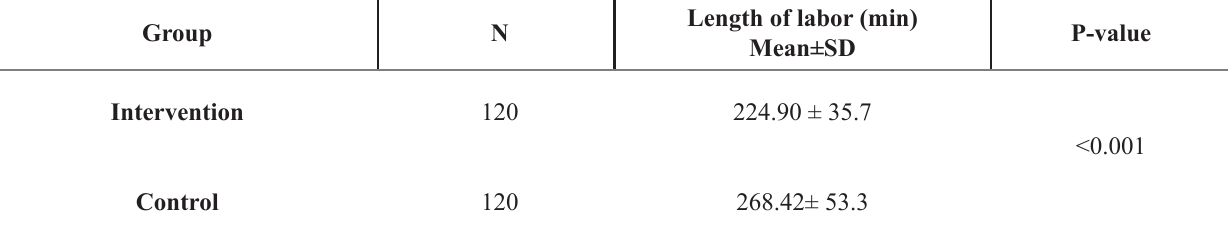
Table 2. Comparing the labor length of the active phase in the control and intervention groups